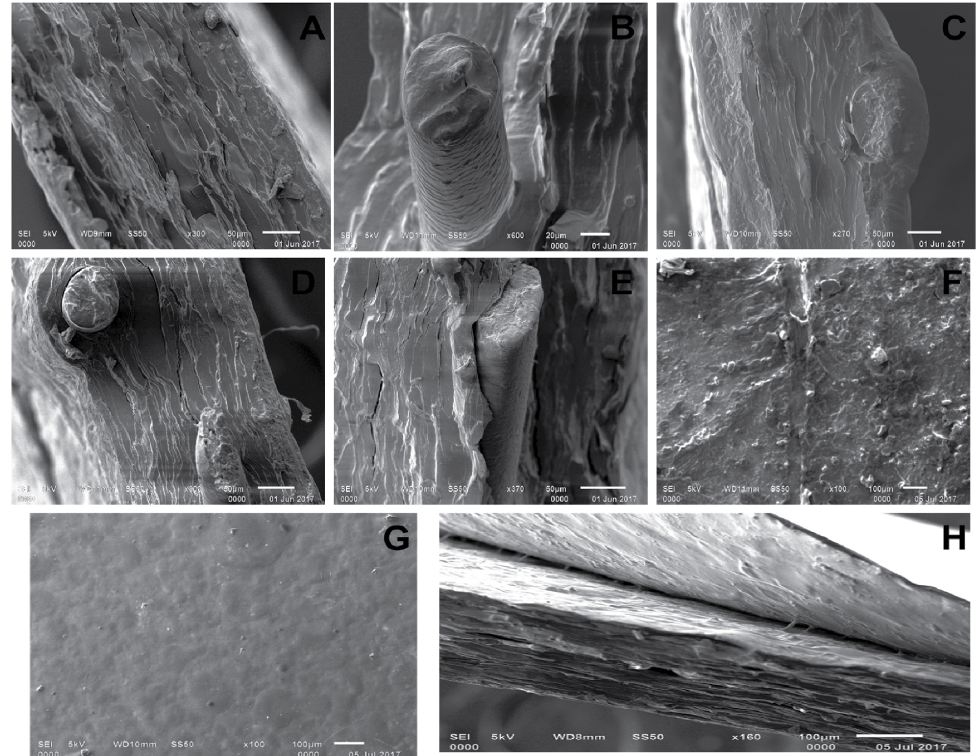
Figure 1: SEM image of SPI-based blend films (A) 0 wt.% human hair, (B) 1 wt.% human hair, (C) 2 wt.% human hair, (D) 3 wt.% human hair, (E) 5 wt.% human hair, (F) non-coated surface of SPI composite, (G) coated surface of SPI composites and (I) chitosan coated surface making adhesive